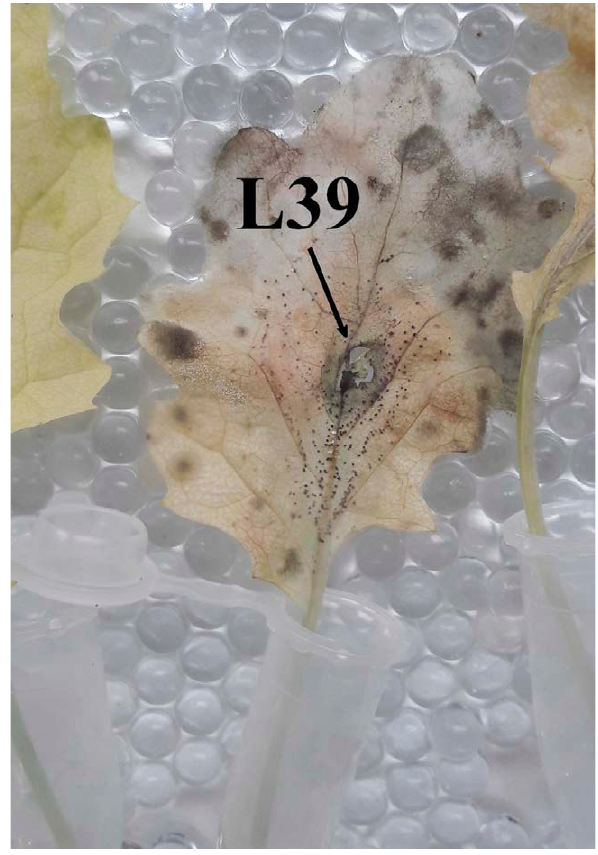
Figure 4. Necrotic lesion and pycnidia (arrow) caused by Plenodo- mus biglobosus (isolate L39) on an inoculated oilseed rape leaf after 10 d incubation.